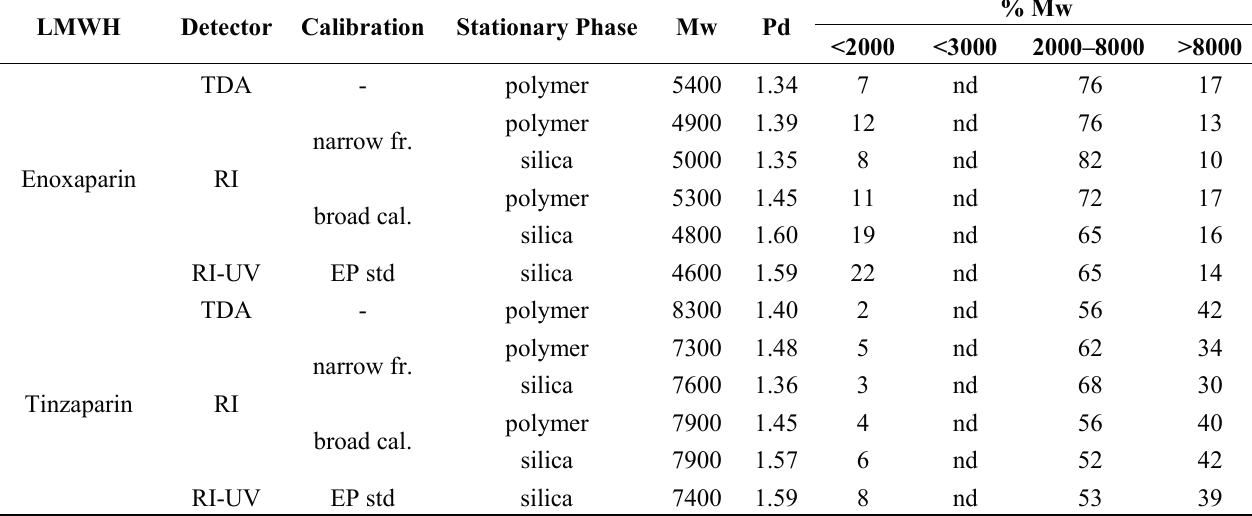
Table 4. Comparison of the molecular weight profiles of enoxaparin, tinzaparin, dalteparin and fondaparinux obtained by HP-SEC/TDA method, and conventional HP-SEC/RI or HP-SEC/RI-UV by applying five different calibration methods: with narrow fractions or broad calibrant on both polymeric and silica gel columns, and with the EP standard on silica gel columns. Mw values were rounded off to the nearest hundred for LMWHs and to the nearest ten for fondaparinux. (nd: not